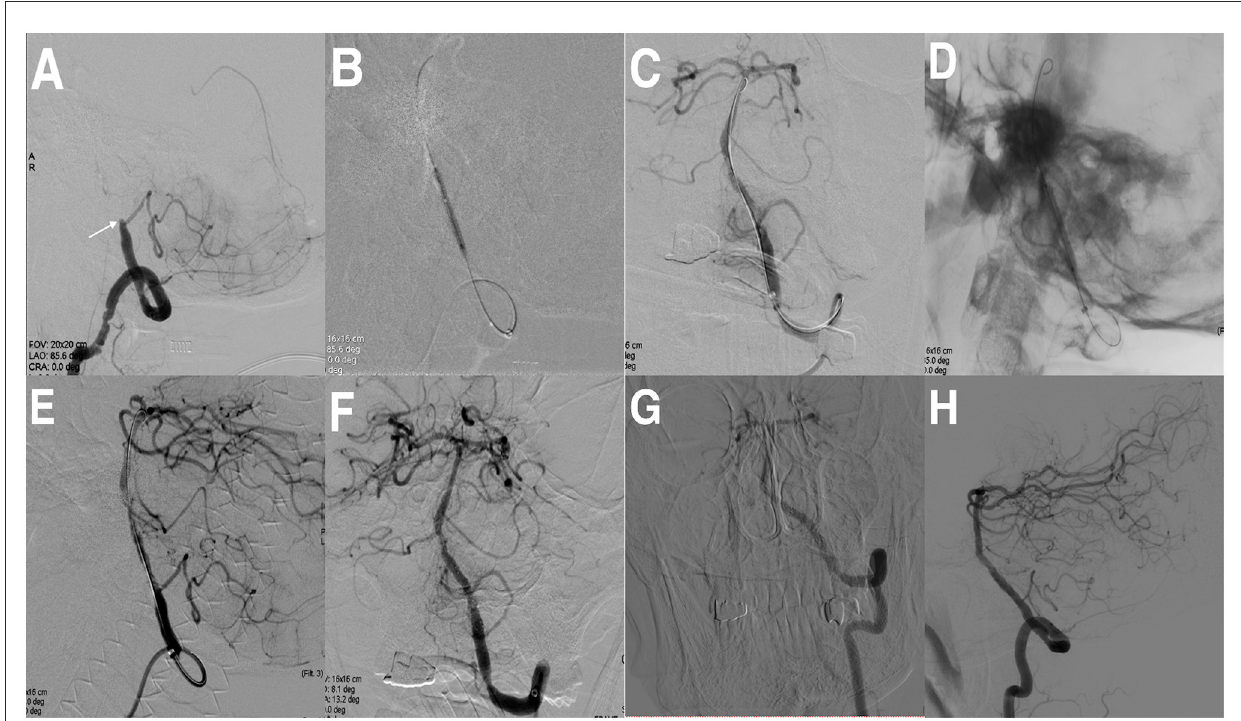
FIGURE2 Cerebral angiographic results of drug-coated balloon (DCB) dilatation and stenting implantation for intracranial vertebral artery (ICVO) during the procedure and follow-up. (A) ICVO (the arrow indicates the occlusion site). (B) Predilation with a conventional balloon. (C) Angiographic result after predilatation with a conventional balloon. (D) Predilatation with DCB. (E) Angiographic result after predilatation with DCB. (F) Angiographic result after stenting implantation. (G, H) Angiographic result at the 8-month follow-up with a patent vertebral